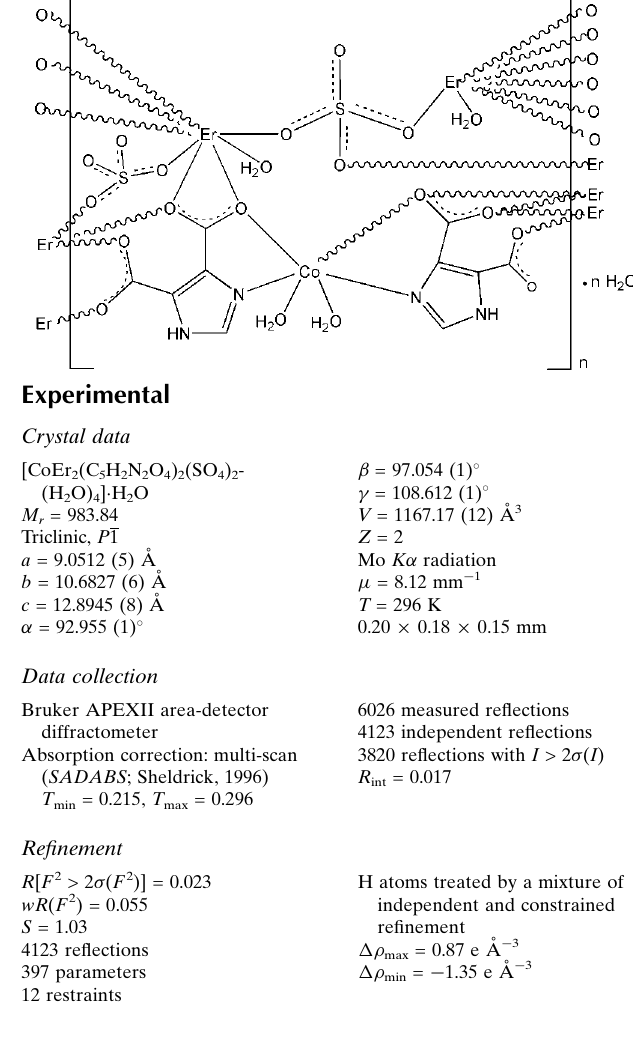
Hydrogen-bond geometry (A˚ , (cid:4) ). D —H (cid:2)(cid:2)(cid:2)